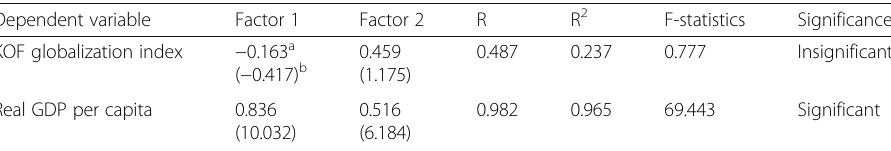
Table 4 Results of regression